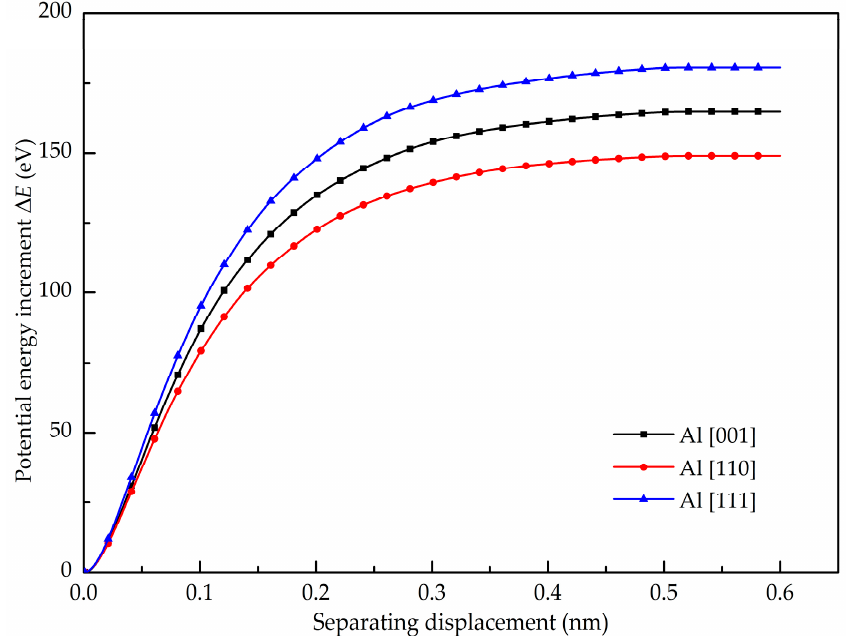
Figure 17. Potential energy increment during the cohesive law simulation.